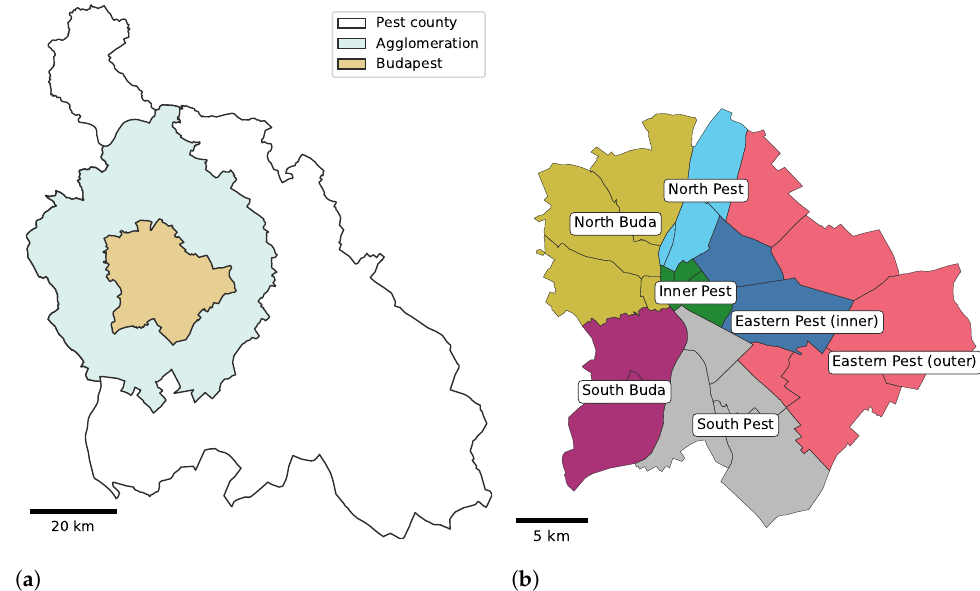
Figure 1. The observation area ( a ) including Budapest (brown), and its agglomeration (green) in relation to Pest county, and the district groups ( b ) of Budapest, defined by the Hungarian Central Statistical Office (HCSO).